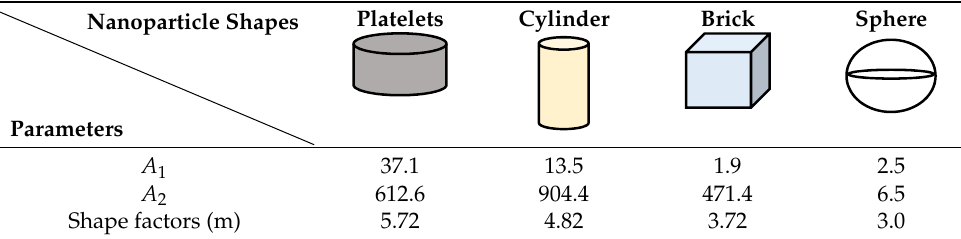
Table 2. Viscosity and shape factor values of nanoparticles.